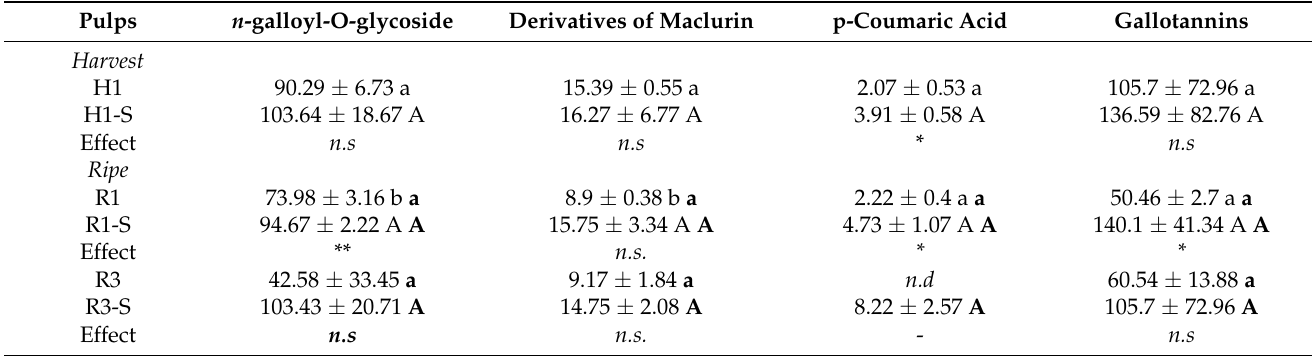
Table 5. Quantification of phenolic compounds in the pulp of cv. ‘Cogshall’ mango depending on harvest and ripening stages (H1, R1 or H3, R3 stages) and irrigation conditions (highest rates of irrigation and non-irrigated (“S”) trees). Identical letters indicate non-different values. Lowercase letters indicate the comparisons between control fruits, uppercase letters indicate the comparison between fruits from the water deficit treatment. Bold letters indicate the effect of the harvesting date (R1 R3), the others indicate the effect of ripening (H1 R1). n.s., *, and ** mean that the effect of irrigation treatment is non-significant, significant at p < 0.05, and p < 0.01, respectively, for each maturity stage.